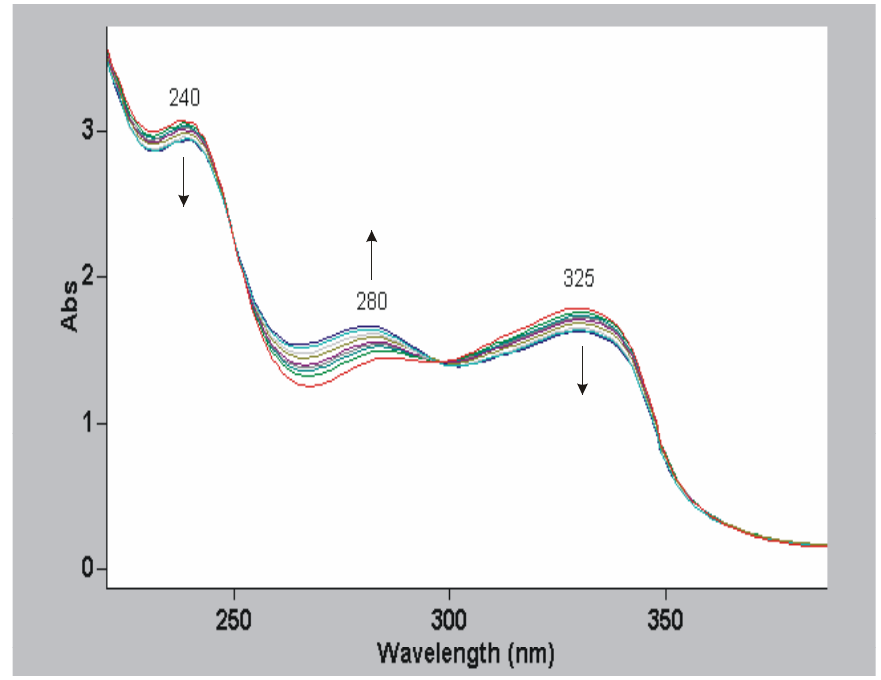
Figure 4. The UV spectra of the decomposition of the complex of Mn(III)-diacetylacetonemaleate in ethanol with time (30